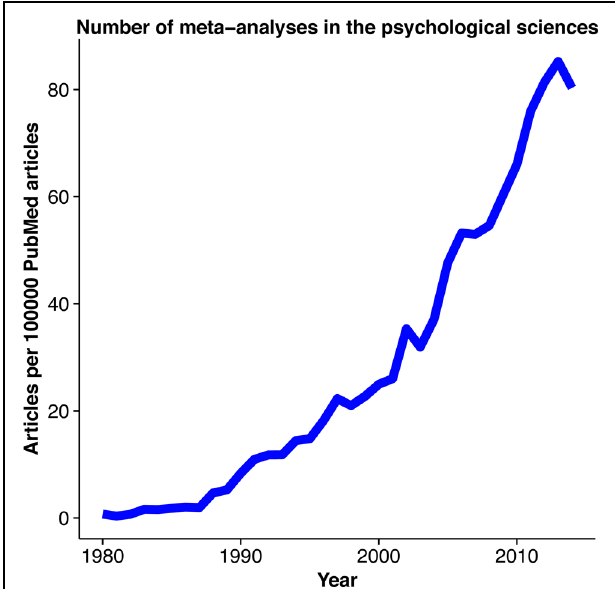
FIGURE 1 | Meta-analysis in the psychological sciences. An illustration of the increasing interest in performing meta-analyses in the psychological sciences. PubMed data was collected on the number of articles containing the search terms “psychology” and “meta-analysis” published between 1980 and 2014 per 100,000 PubMed articles. Data was collected using the ‘RISmed’ R